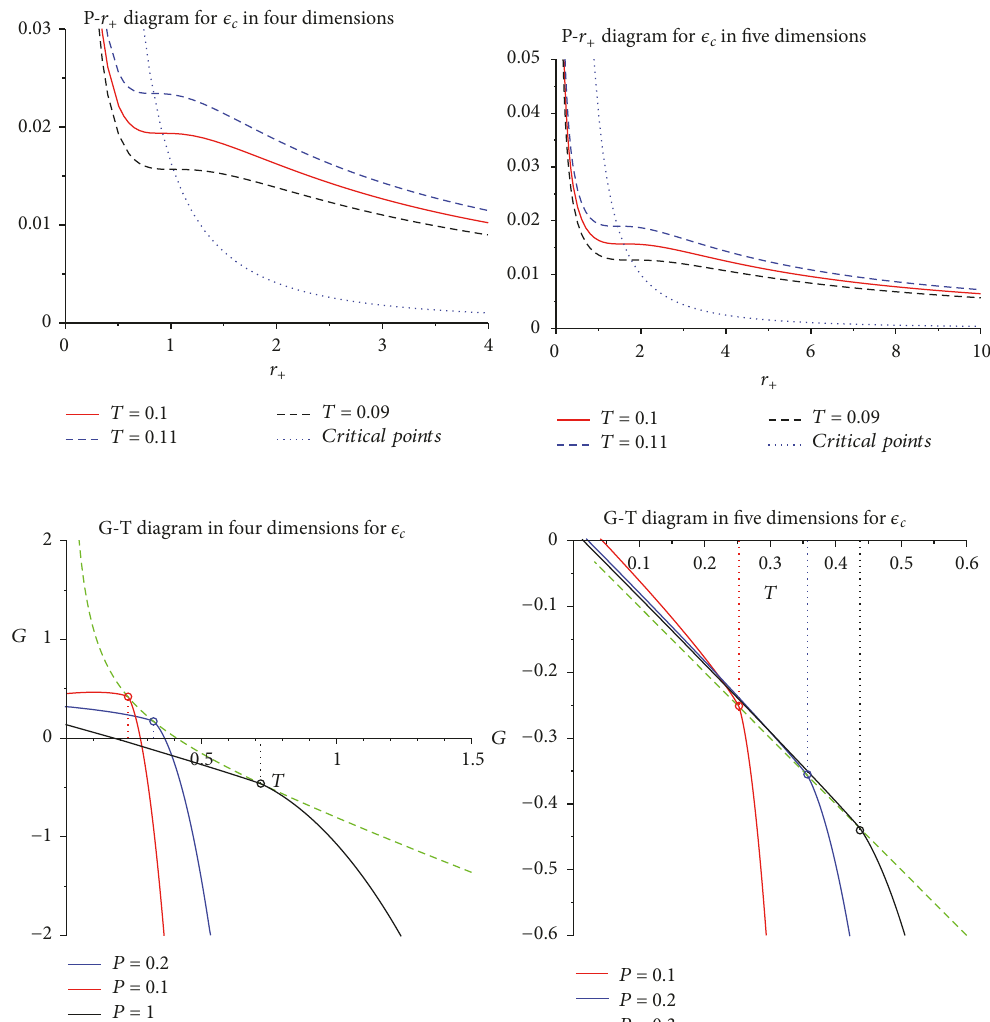
Figure 2: Curves of 𝑃 − 𝑟 + at the different temperature 𝑇 and 𝐺 − 𝑇 at the different pressure 𝑃 in four and five dimensions for 𝜖 = 𝜖 𝑐 . Every isotherm in 𝑃−𝑟 + diagrams is a critical isotherm, and the dotted lines describe the position of all critical points. A line of second-order phase transitions is shown in 𝐺 − 𝑇 diagrams, and the dashed lines describe the position of all phase transition